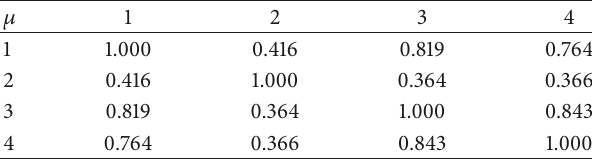
Table 6: Membership parts of the intuitionistic fuzzy pairs, giving the intercriteria correlations between measurements of iris plant.